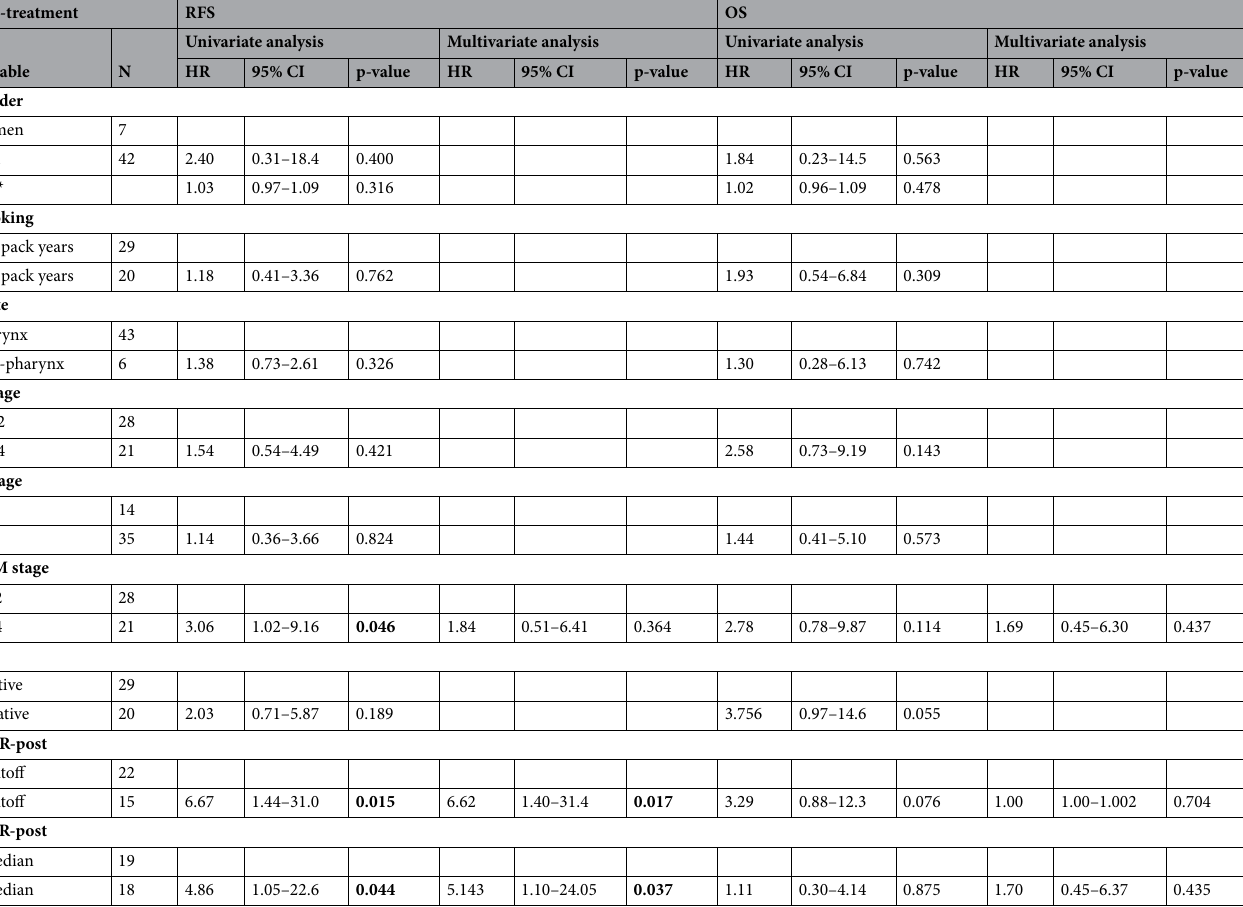
Table 4. Prognostic value of post-treatment plasma uPAR. Cox proportional hazards model for relapse-free survival (RFS) and overall survival (OS) in relation to clinicopathological variables and post-treatment plasma uPAR (uPAR-post) dichotomized according to the established cut-off. Significant values are in [bold]. *Age was included as a continuous covariate. T tumor; N node; M metastasis. Hazards ratio (HR), 95% confidence intervals (95%